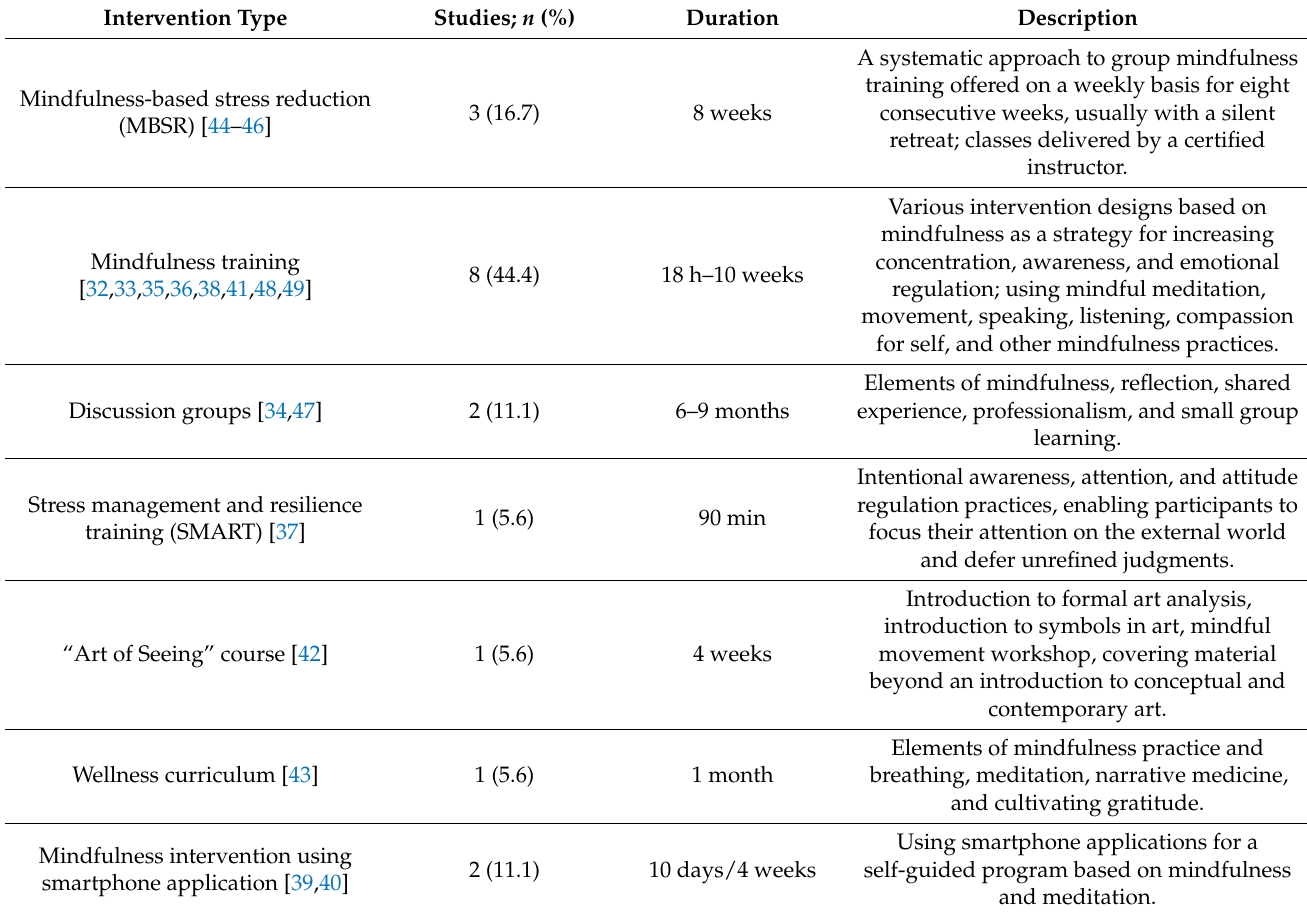
Table 2. Summary of intervention